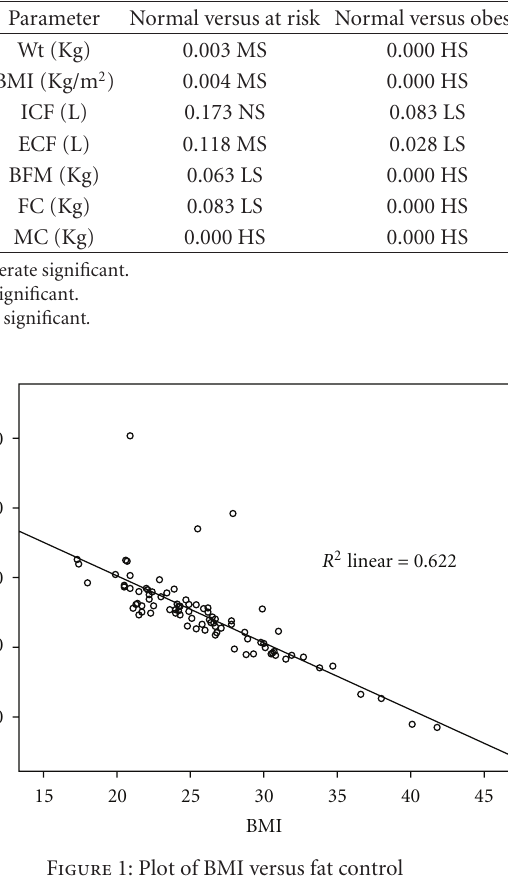
Table 2: Significance of each parameter with normal group as the basis against all obesity groups in South Indian female population (at risk, obese).